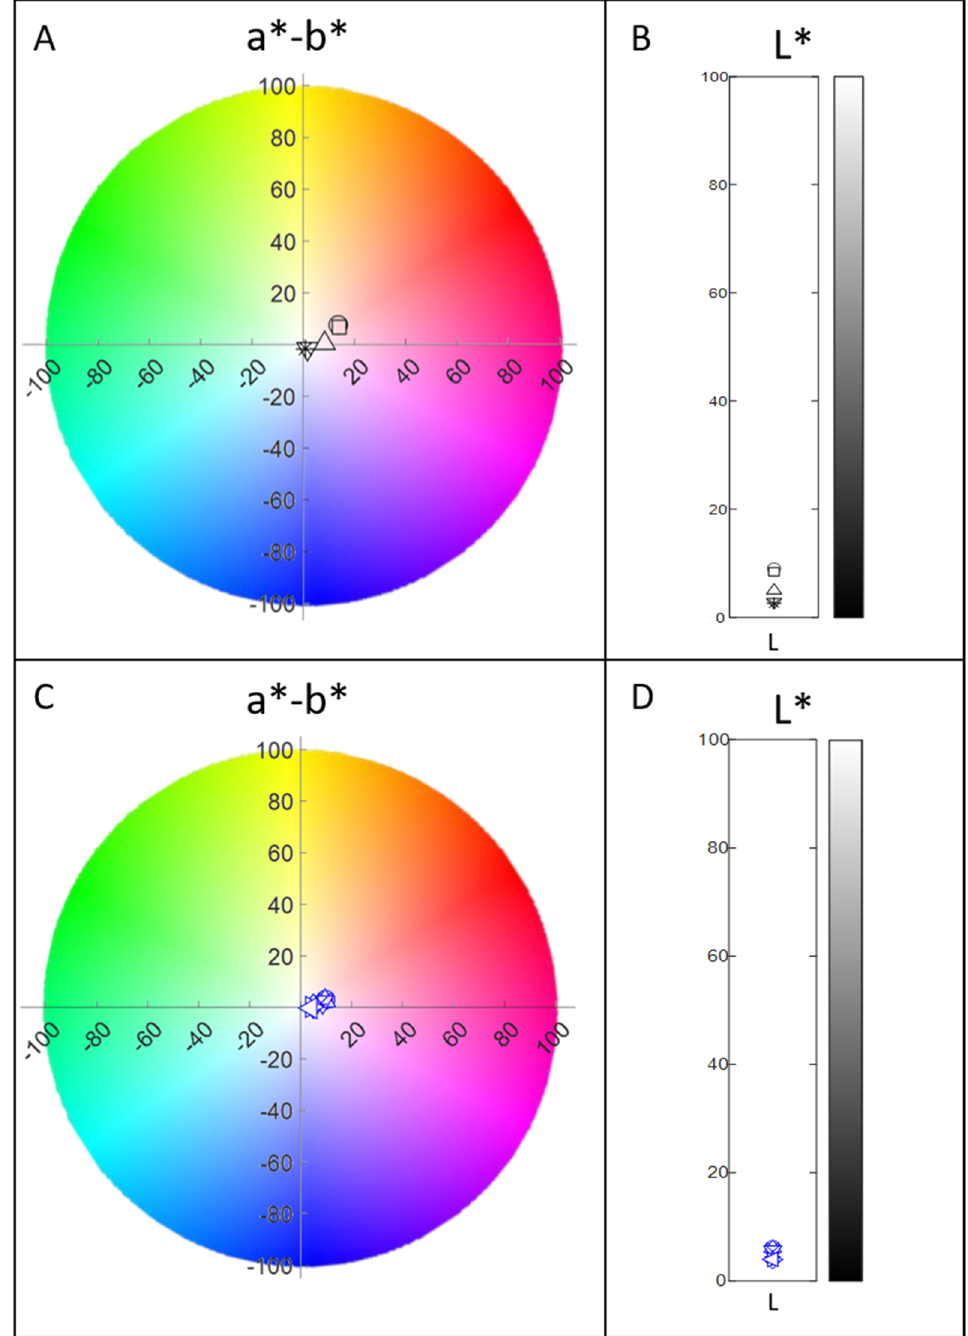
Figure 3. CIELAB graph presenting a*-b* and L* values given by the colorimetry at different pH values of extracted pigments from Pigment Complex A ( A , B ) and Pigment Complex B ( C , D ).